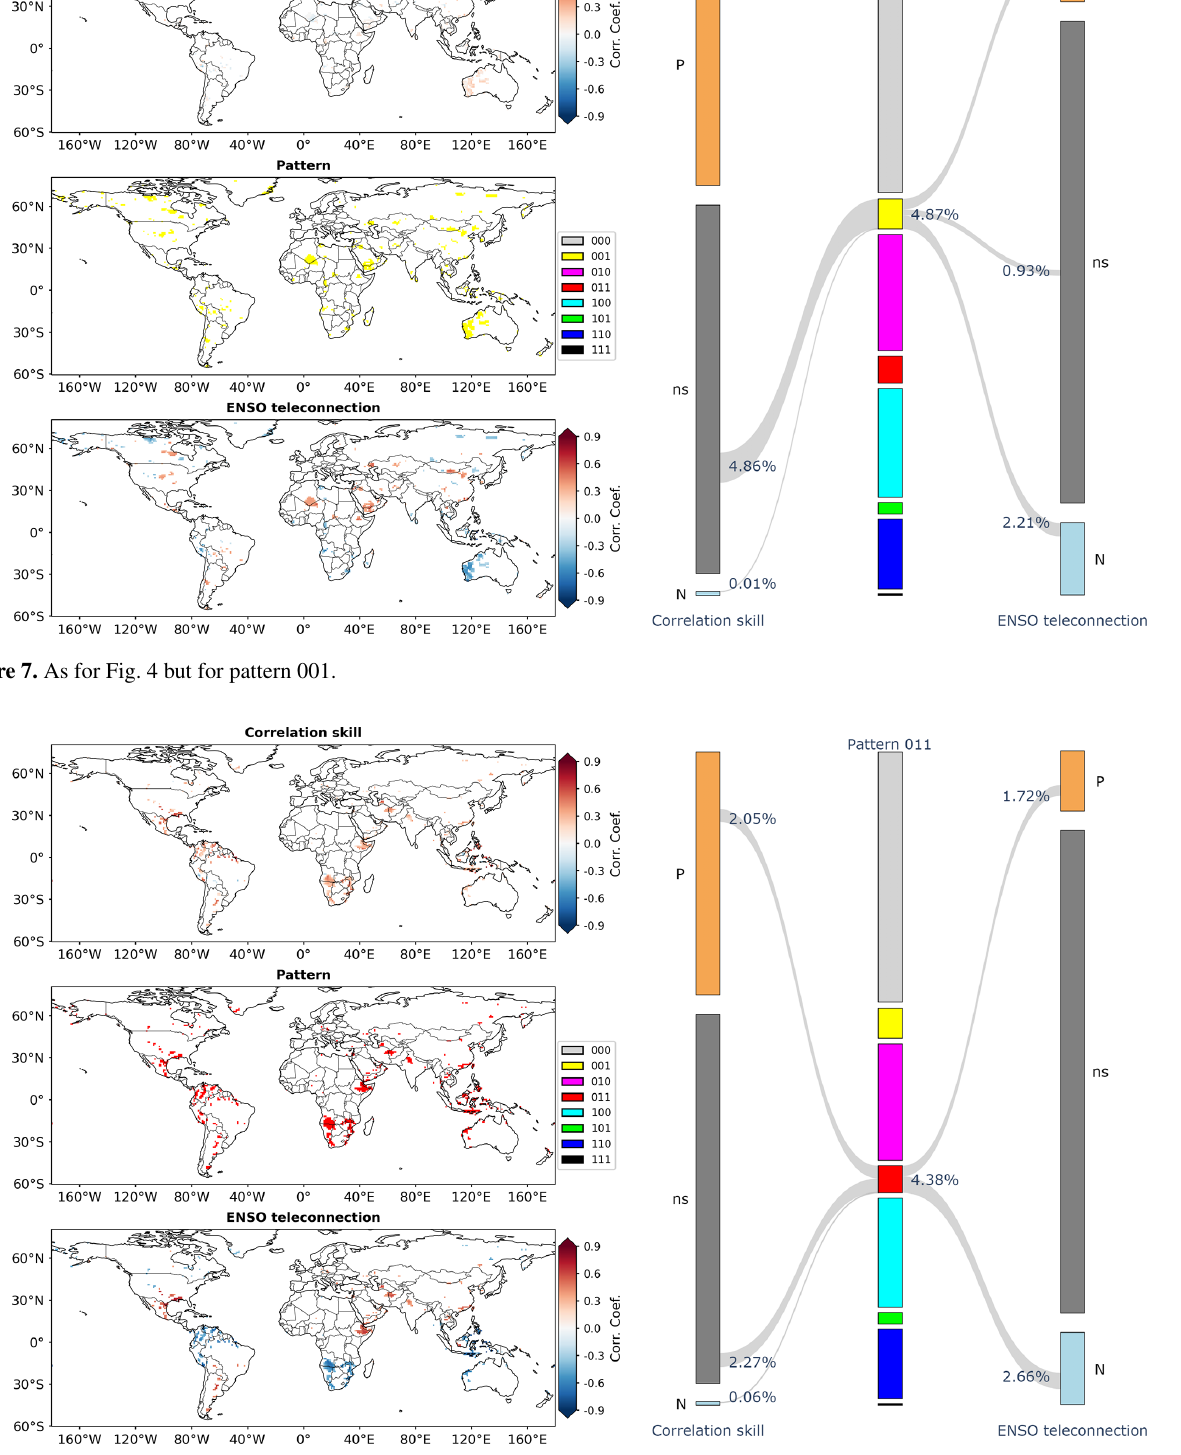
https://doi.org/10.5194/hess-26-4233-2022 Hydrol. Earth Syst. Sci., 26, 4233–4249,